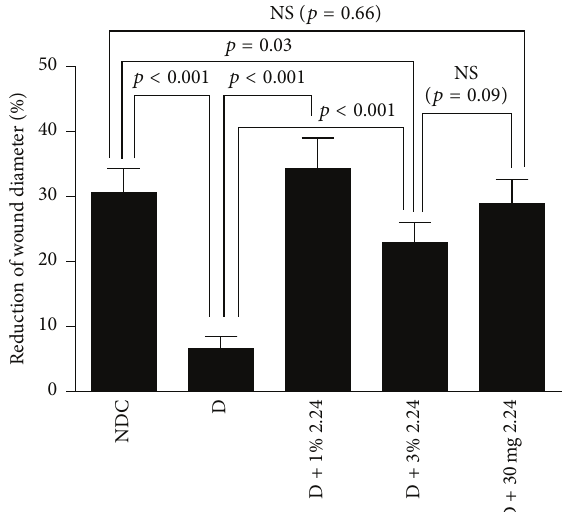
Figure 3: Histomorphometric assessment of healing (% reduction in wound diameter) of skin wounds in normal (NDC) and diabetic (D) rats treated with vehicle alone (D) and in D rats treated topically with either 0.25% CMC2.24 (D + 0.25% 2.24) or curcumin (D + 0.25% cur) or 1% CMC2.24 (D + 1% 2.24) or curcumin (D + 1% cur). Each value represents the mean ± SEM for 18 measurements per experimental group (3 rats/group).